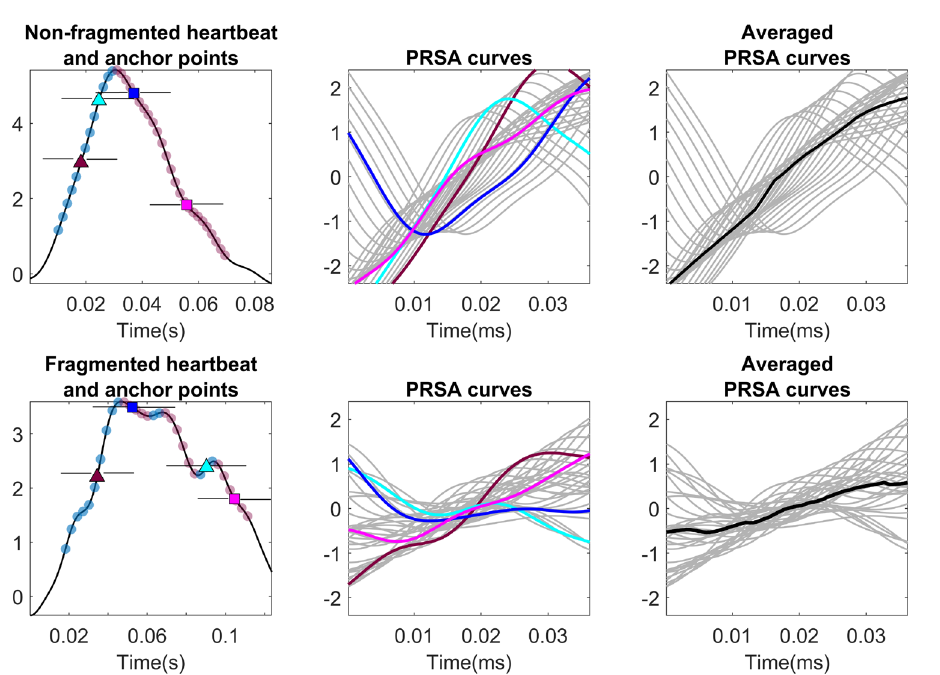
Figure 4. Examples of the PRSA procedure for the analysis of a non-fragmented and a fragmented QRS complex. The first column shows the signal and some examples of the sliding window centers located along the QRS complex. The blue points correspond to samples in increasing segments of the signal, and the pink ones to descending points. The second column shows the PRSA curves extracted around each of these samples, with a length of 40ms. Those corresponding to descending points were inverted so they all follow an comparable trend. The last column shows in black the averaged PRSA curve on top of all the contributing